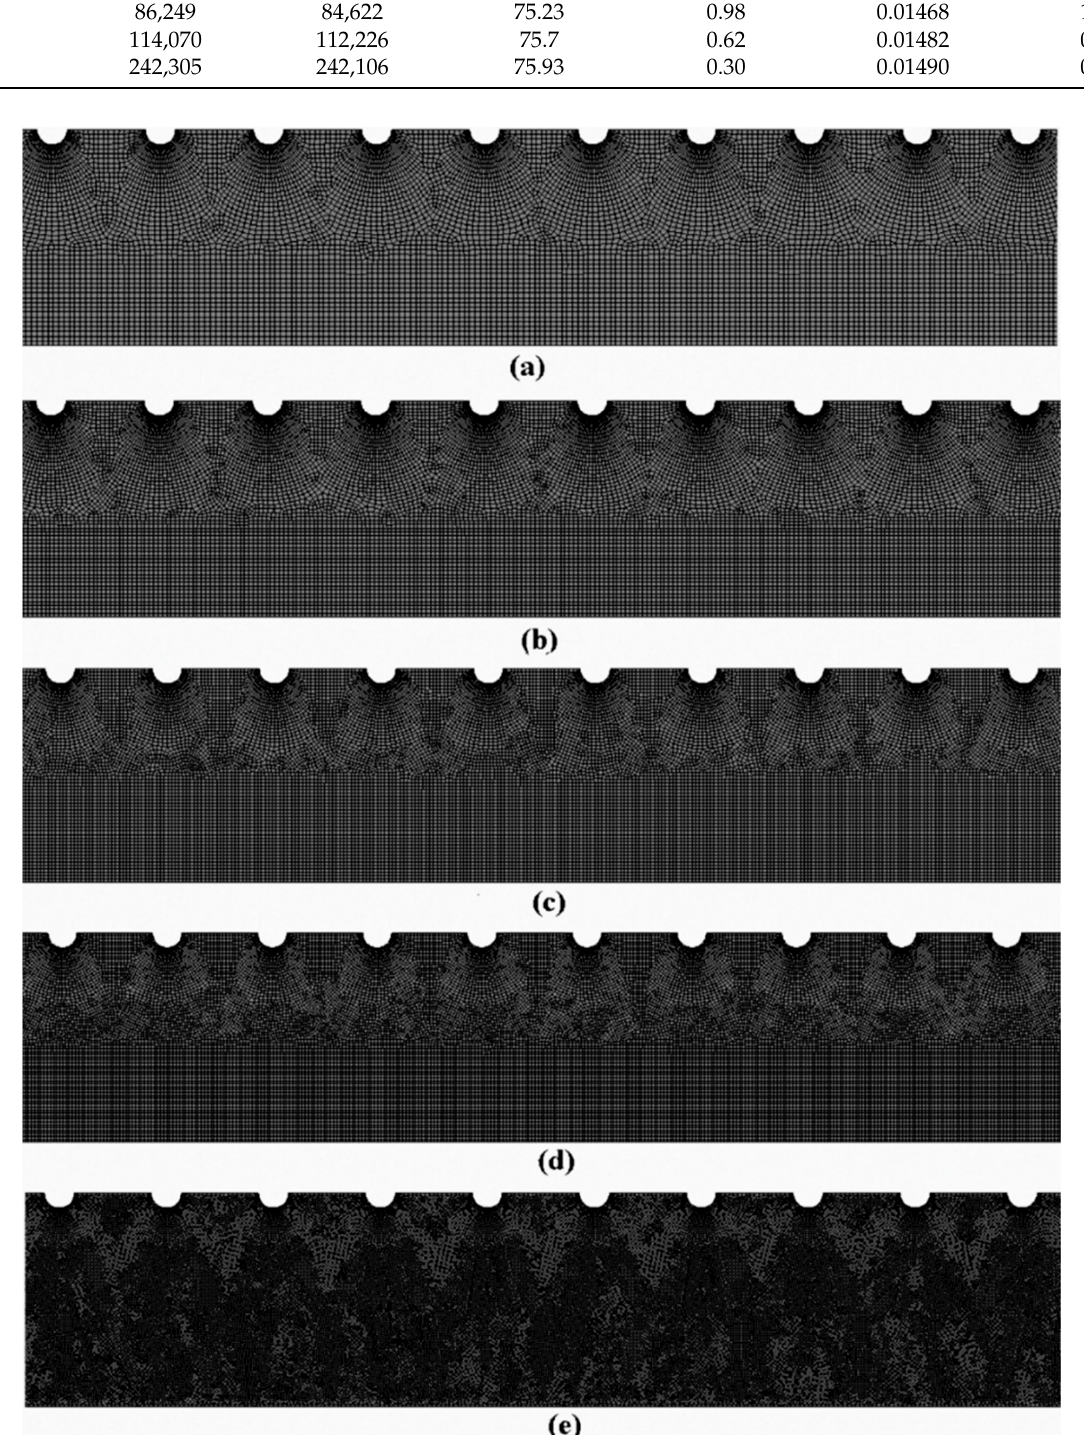
Figure 4. The computational grids with cell numbers of ( a ) 44,473, ( b ) 68,524, ( c ) 84,622, ( d ) 112,226, and ( e ) 242,106.